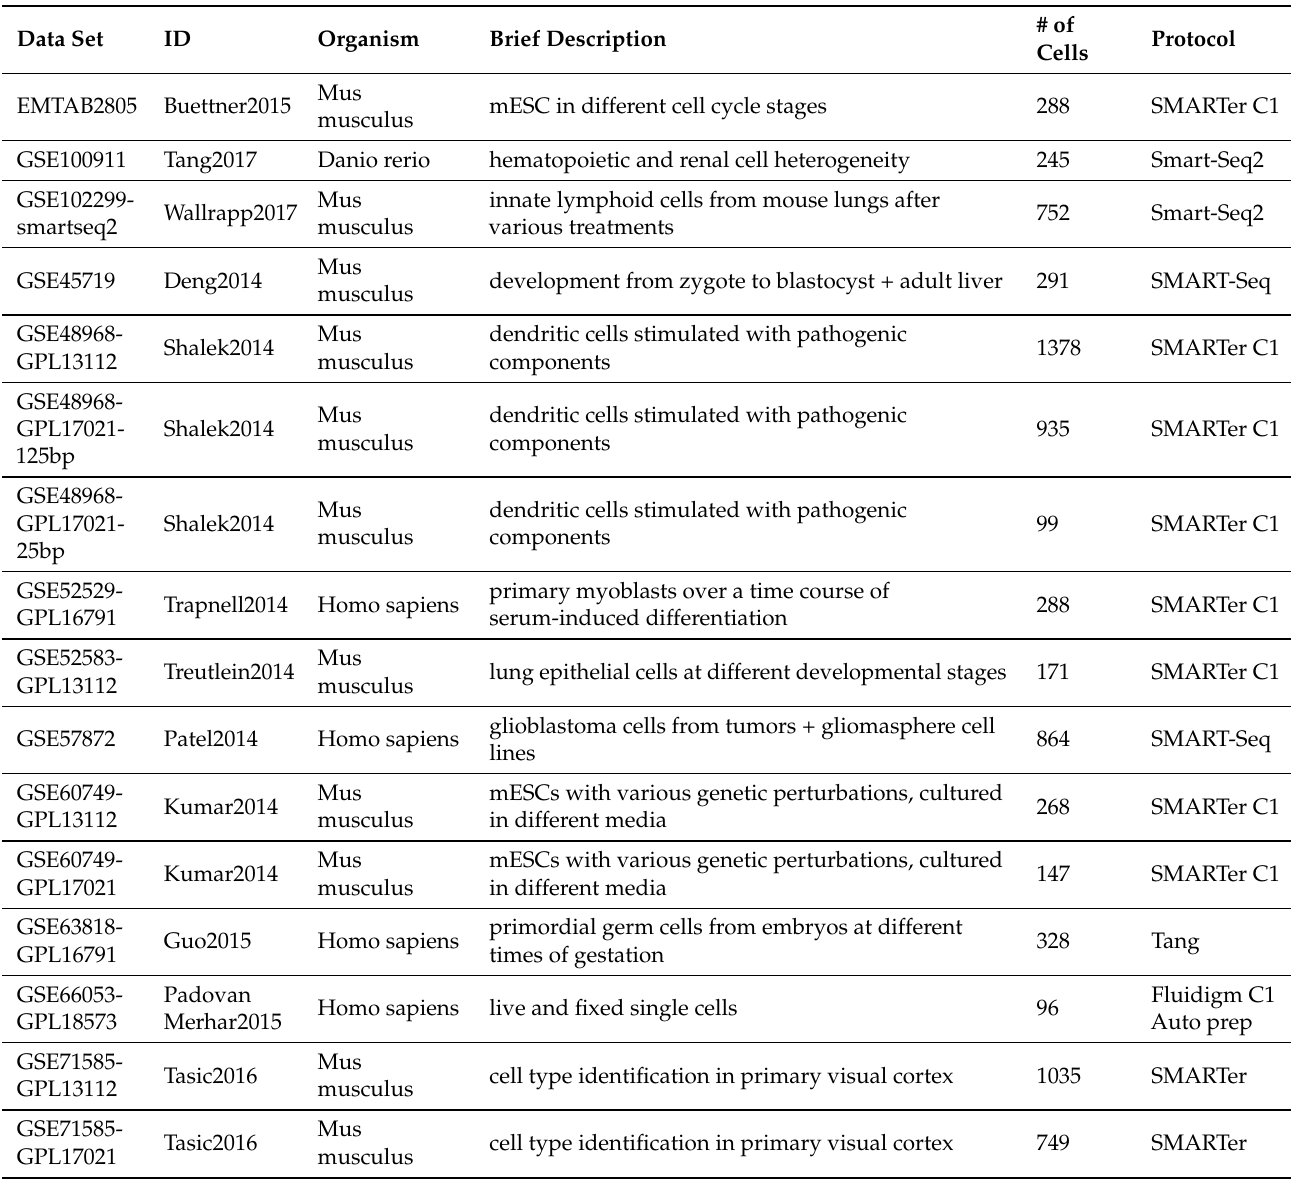
Table 1. List of selected data sets along with their IDs, organisms where the cells were taken from, a brief description, cell counts and sequencing protocols used. Data